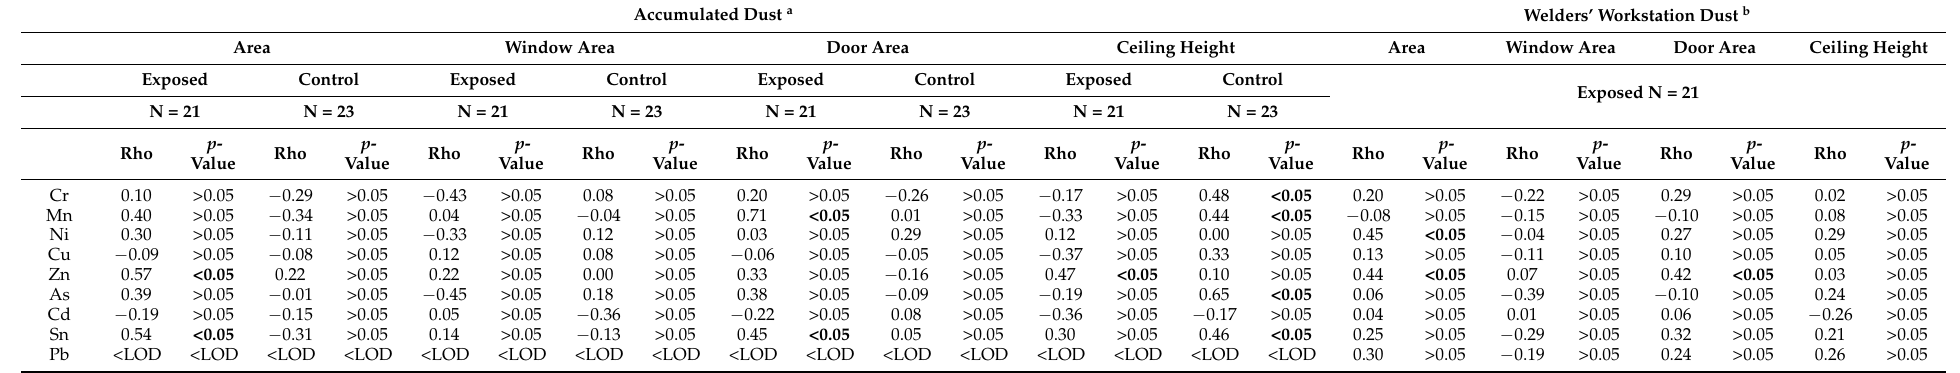
Table 4. p -Values of Spearman correlations between PTE levels in dust samples and physical infrastructure by group. Limeira, Brazil, 2019. Accumulated Dust a Welders’ Workstation Dust b Window Area Door Area Ceiling Height Area Window Area Door Area Ceiling Height Exposed Control